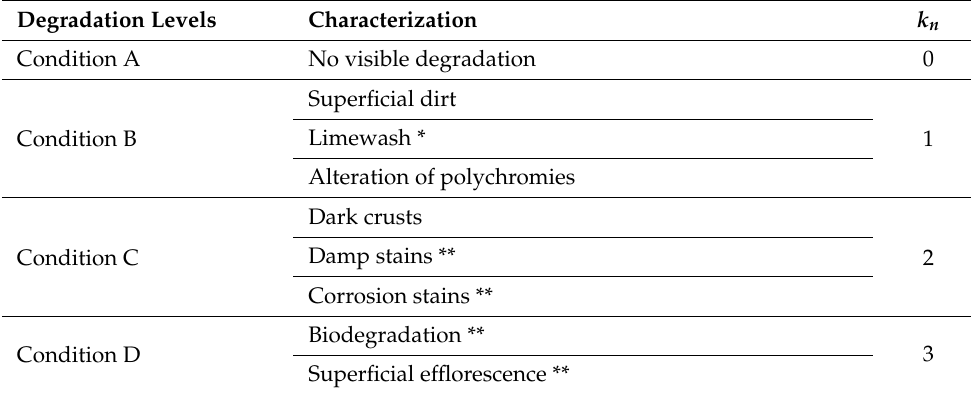
Table 4. Classification of aesthetical anomalies.